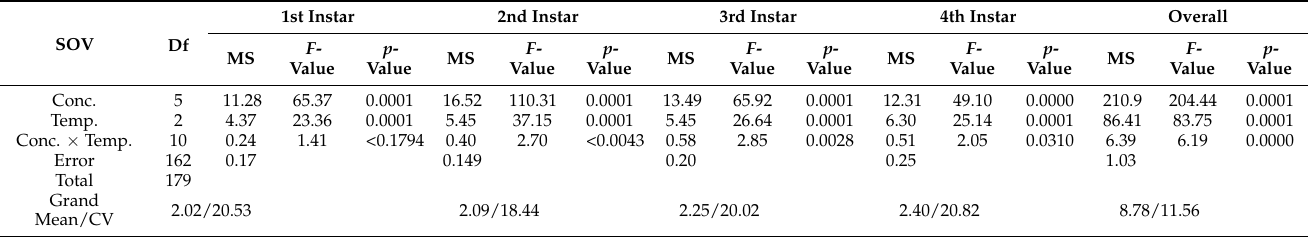
Table A3. Nymphal development time of ( M. persicae ) in relation to PeBC1 elicitor and temperature (ANOVA). 1st Instar 2nd Instar SOV Df Conc. 0.24